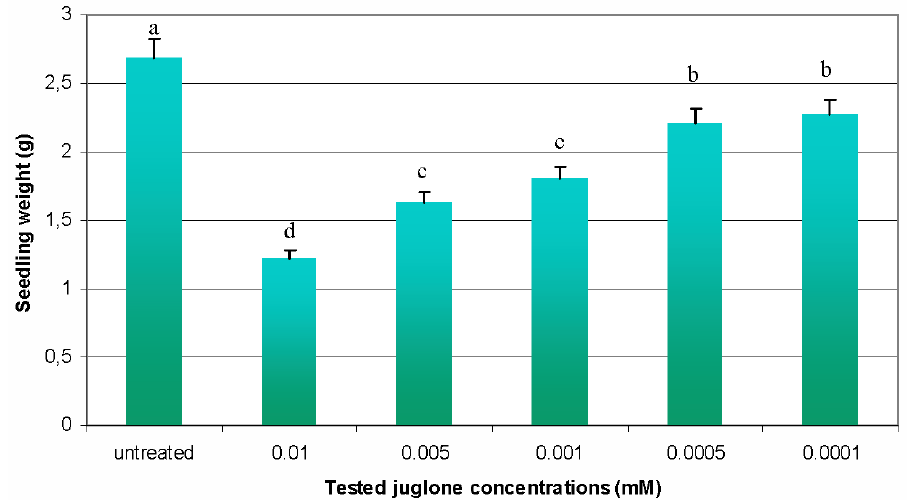
Figure 3. Influence of juglone on maize seedling weight. Values denoted with different letters are statistically significant at p < 0.01 (Duncan’s multiple range test). Parameter was recorded at the 8th day of the